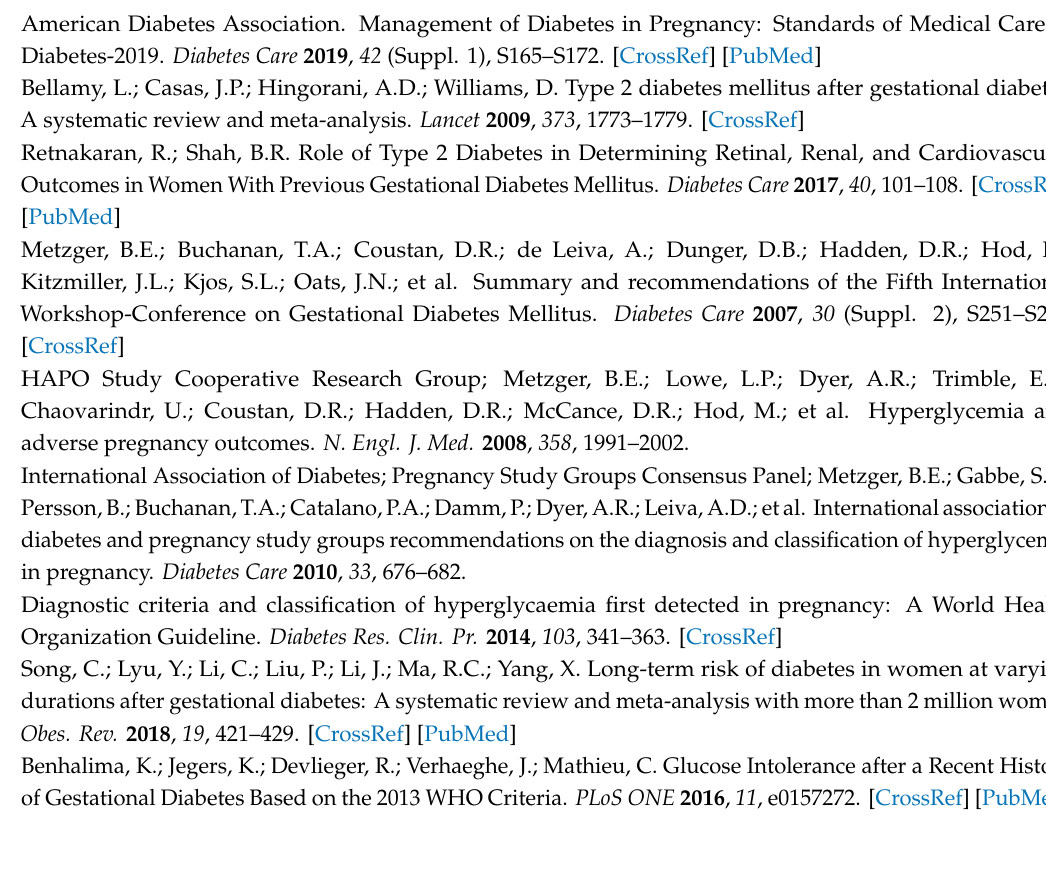
Table S1: Detailed search strategy; Table S2: Sensitivity analyses; Table S3: Assessment of quality of studies by NOS; Figure S1: Funnel